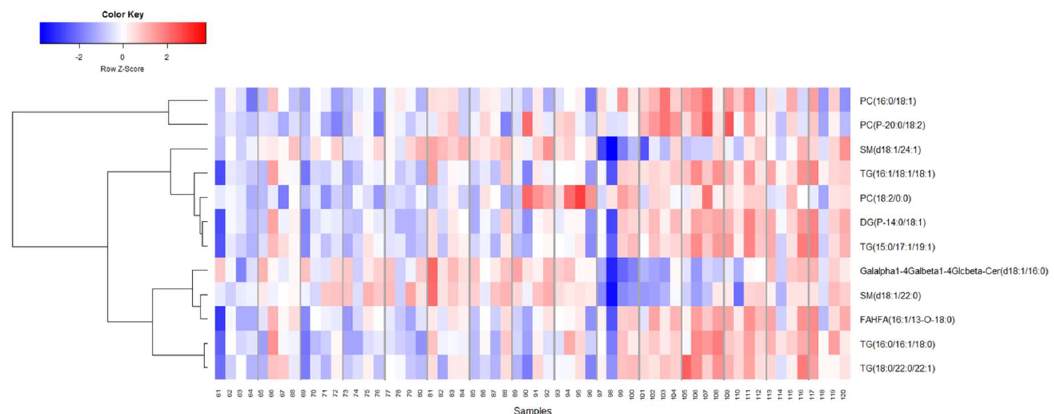
Figure 8. Hierarchical clustering shows longitudinal changes in sphingomyelin and glycerophosphocholine classes of lipids in NHPs that received BIO 300 administered po .